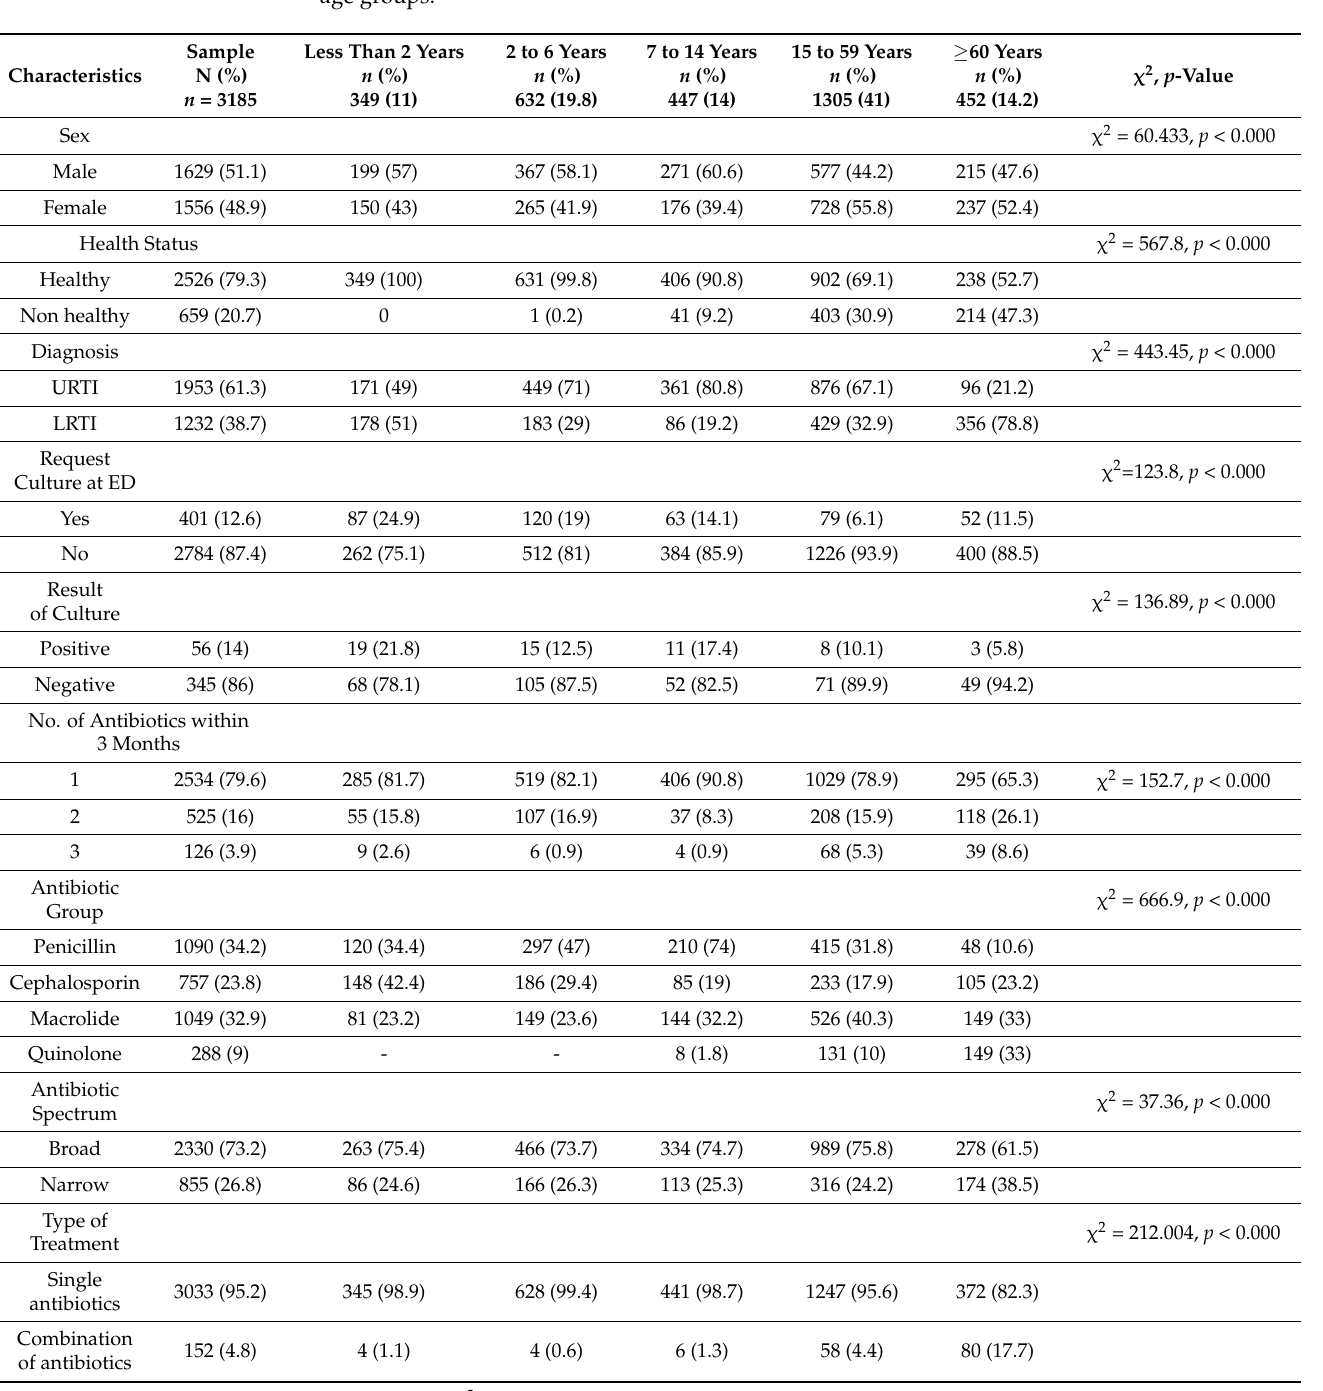
Table 1. Bivariate analysis of patient characteristics and antibiotic prescriptions compared by age